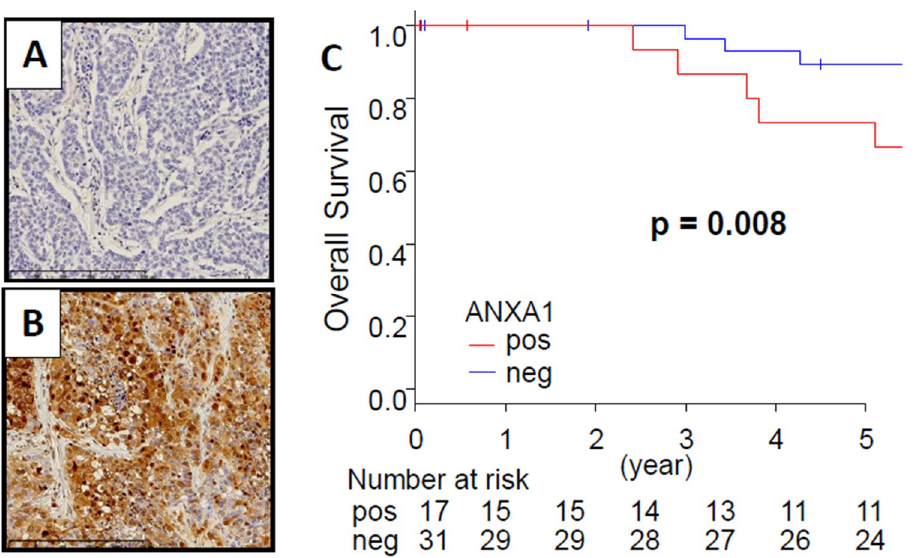
Figure 1. Annexin A1 (ANXA1) protein expression is associated with overall survival in a Japanese triple-negative breast cancer (TNBC) cohort. Representative images of ANXA1 immunohistochemical staining in breast cancer. ( A , B ) Negative and positive ANXA1 staining in breast cancer tissue. × 400 magnification. ( C ) Overall survival in a Japanese TNBC cohort. Positive and negative ANXA1 protein staining results are represented by the red and blue lines, respectively. Bold font indicates a significant di ff erence. ( p < 0.01).